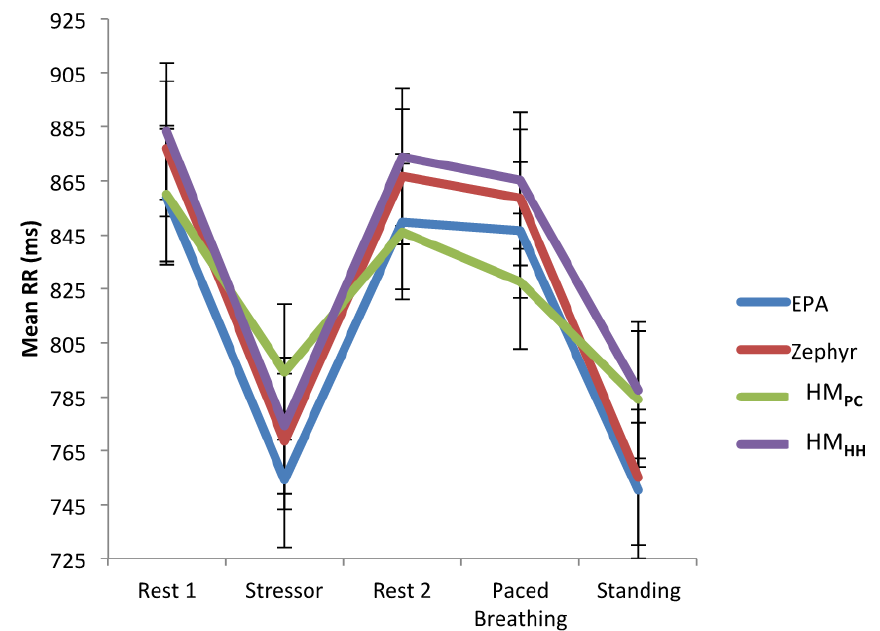
Figure 1. Mean RR values: When aggregating data across both sessions, there was a main effect of segment, indicating a general decrease in Mean RR from initial rest, in response to the stressor, followed by a general increase during the recovery portion of the paradigm and then a slight decrease in Mean RR during the standing segment ( F = 65.42, p < 0.001); There appeared to be a main effect of device, such that HM HH tended to display greater Mean RR values compared to EPA6 ( F = 3.42, p = 0.018); and when examining the interaction between device and segment all 4 devices tended to vary in a similar pattern throughout the session ( F = 0.75, p = 0.70). Data from a linear mixed model with two fixed factors (device, segment) and a random subject effect to calculate the difference between devices and between sessions. Analogous diagrams for five other HRV measures are in the Supplement.